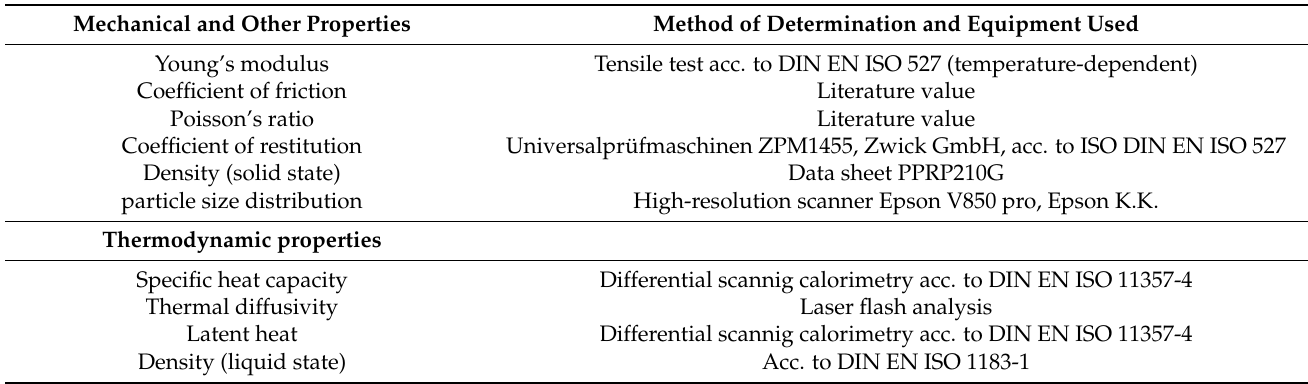
Table A1. Overview of the required parameters for the CFD-DEM simulation and determination method. Mechanical and Other